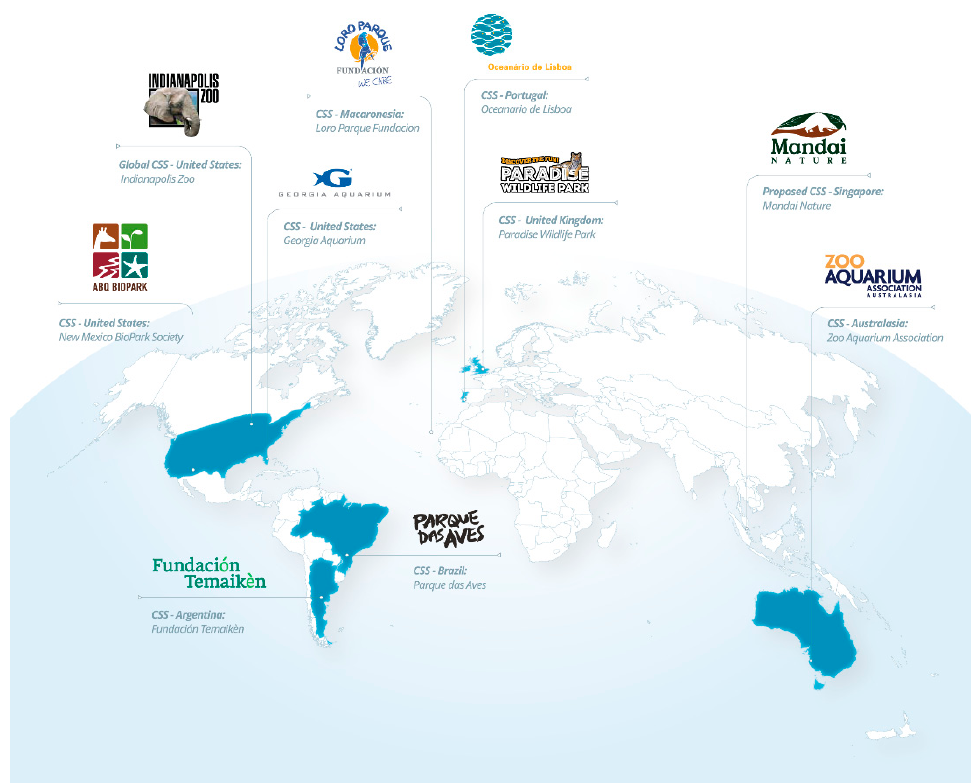
Figure 3. Distribution of SSC Centers for Species Survival.